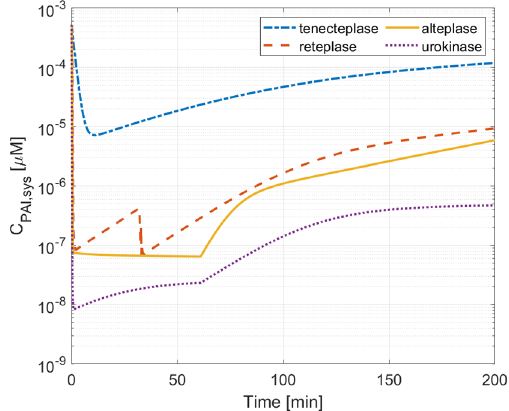
Figure 8. Comparison of PAI-1 systematic concentrations.